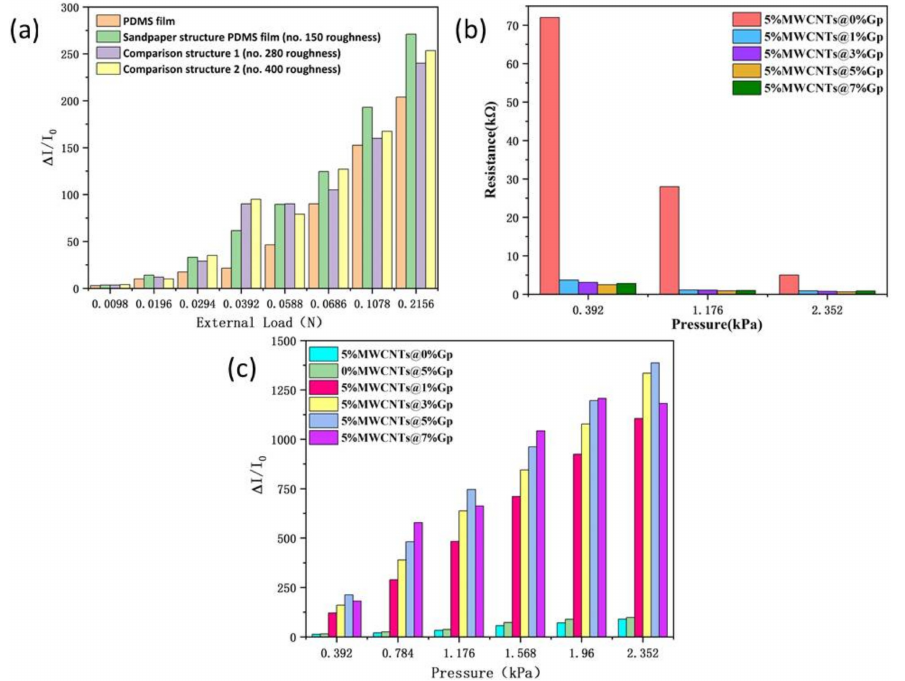
Figure 2. The properties for different doping ratios of Gp. ( a ) Current variation induced by dif- ferent top substrates under different pressures. ( b ) Resistance variation of different Gp doping ratios under different pressures. ( c ) Current variation induced by different Gp doping ratios under different